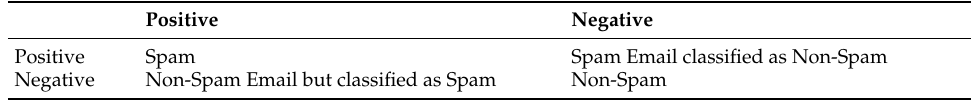
Table 2. Spam filtering confusion